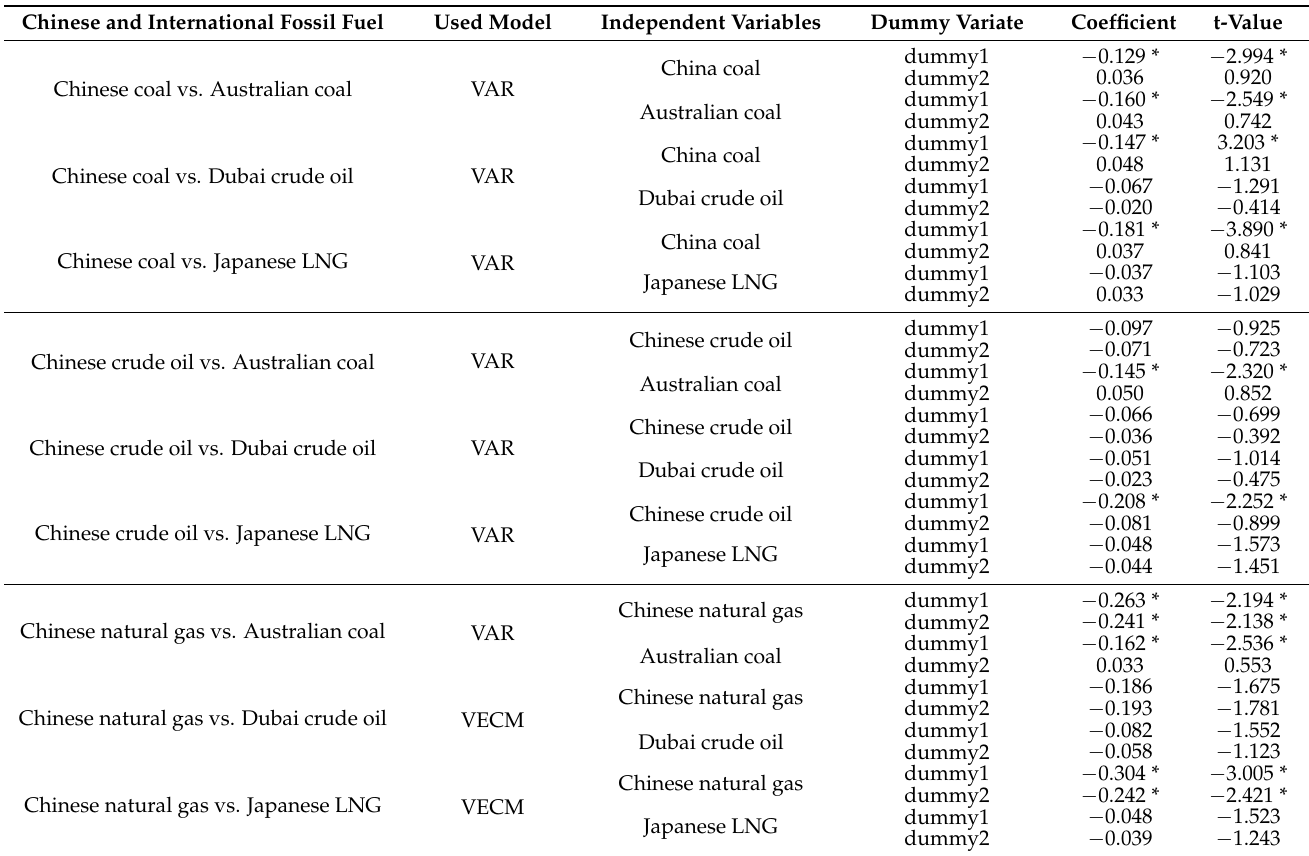
Table 4. Results of the impact of both crises on Chinese and international fossil